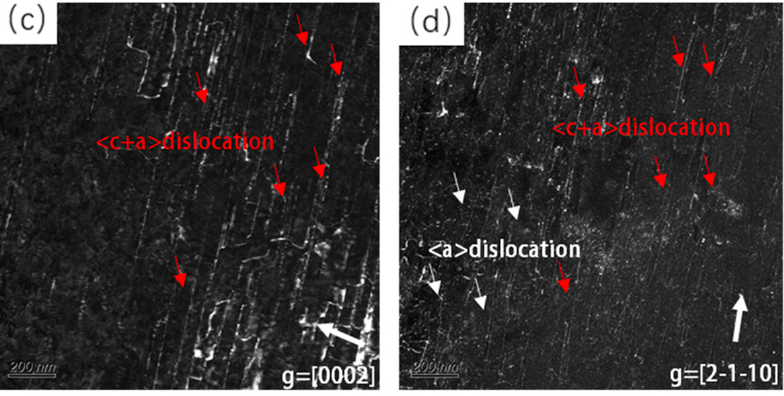
Figure 28. Distribution of dislocations in bright and dark fields [147]: ( a , b ) bright fields;( c , d ) dark fields. Reproduced with permission from Elsevier B.V.